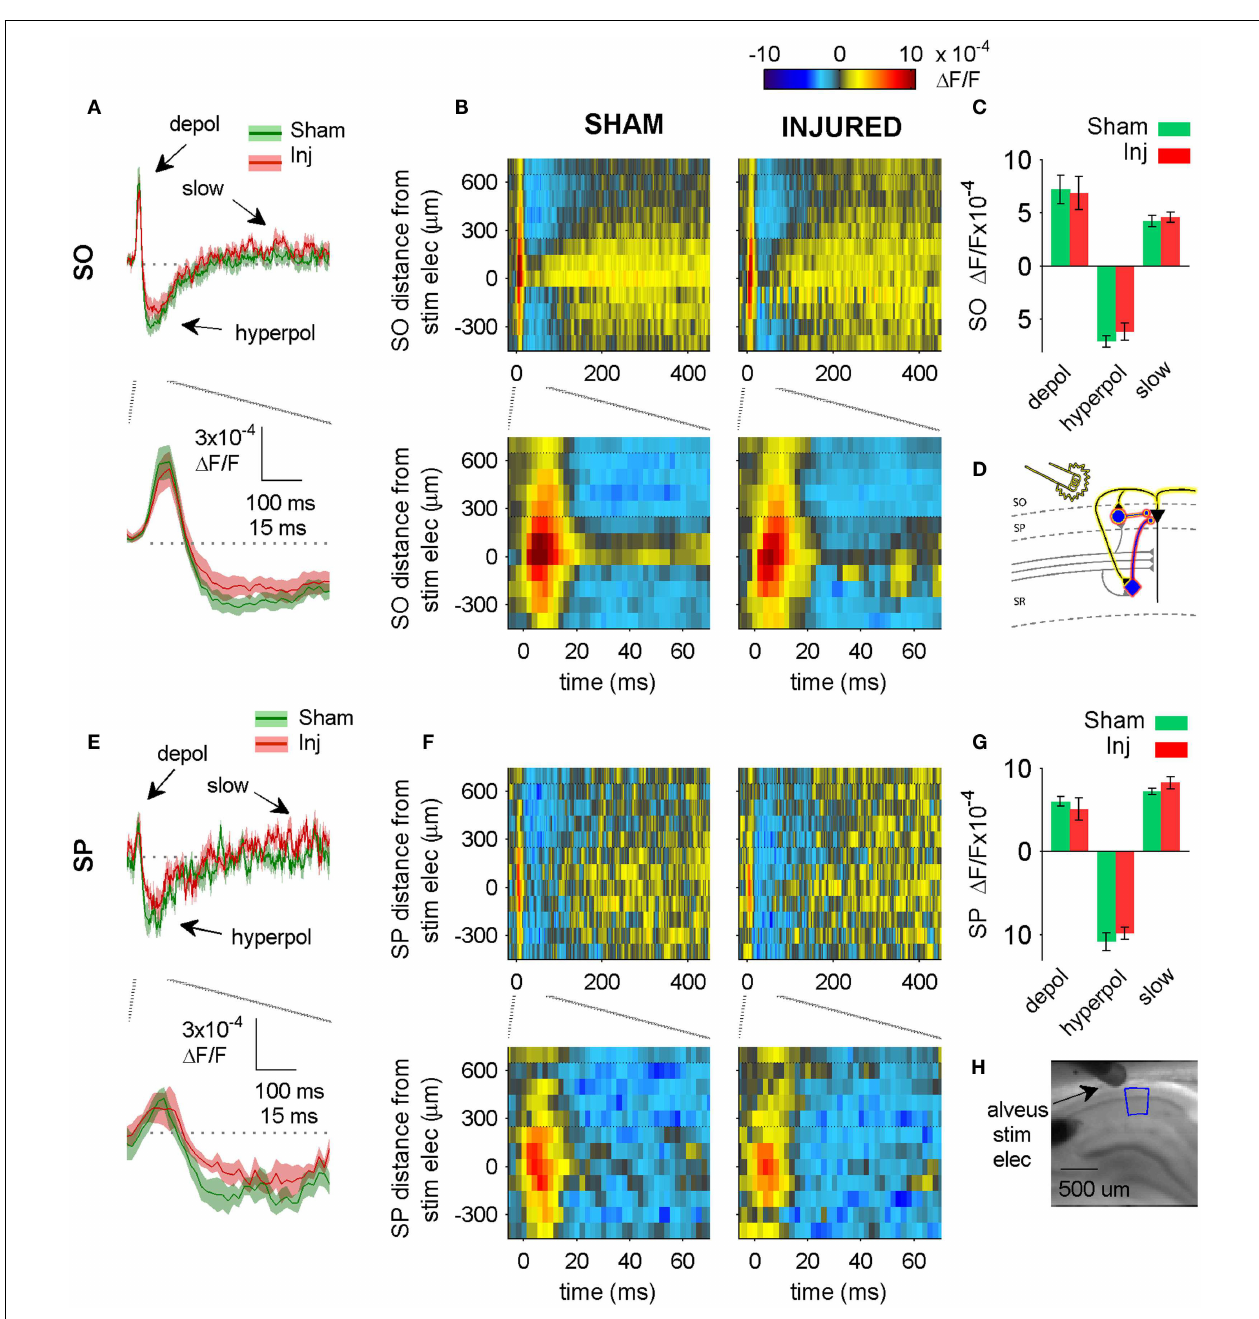
any of the evoked responses. Positive distances are toward subiculum, negative distances are toward CA3. Horizontal dotted lines indicate raster region corresponding to multi-segment analysis region (segments 4–6, toward subiculum). (C,G) Group average statistics. No significant differences were observed. (D) Schematic showing antidromic activation of pyramidal neurons (yellow highlight), and direct (yellow highlight) plus synaptic (red highlight) activation of basket cells by alveus stimulation in aCSF. Schaffer collaterals are shaded gray to indicate non-activation by alveus stimulation. (H) Photomicrograph from a representative slice showing typical location of stimulating electrode and region used for analysis of alveus-stimulated responses. SO, stratum oriens; SP, stratum pyramidale; Inj, Injured; depol, depolarization; hyperpol, hyperpolarization; stim elec, stimulating